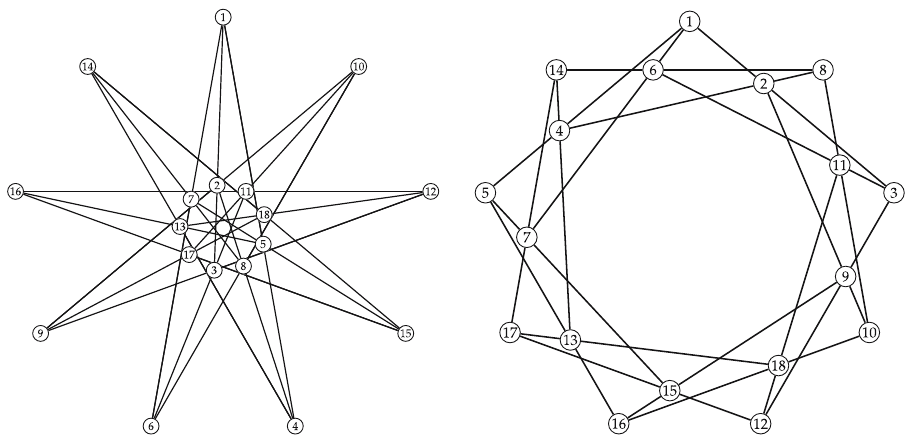
Figure 17: Two cyclic 18 318 - con fi gurations with 18 triangles inducing non - isomorphic triangular matroids.